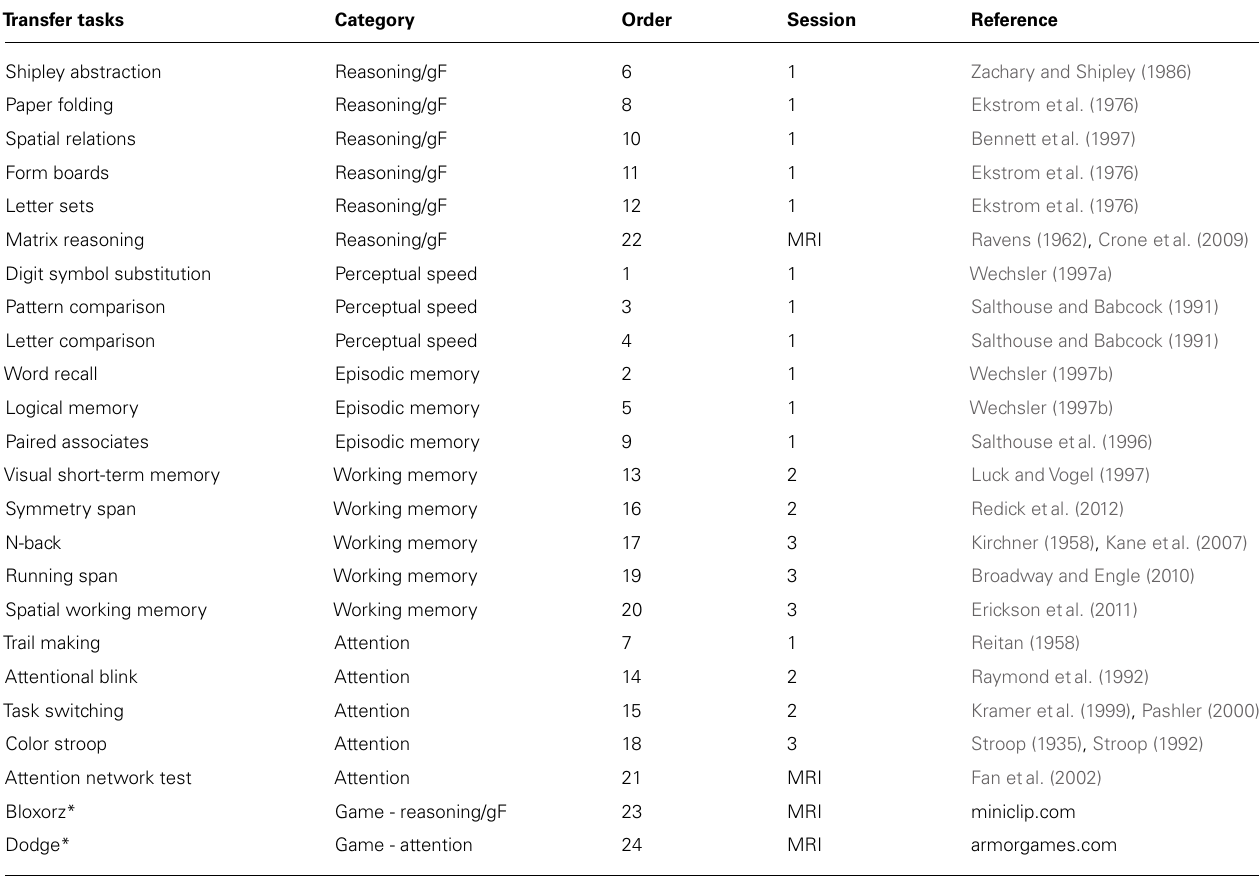
Table 2 |Transfer